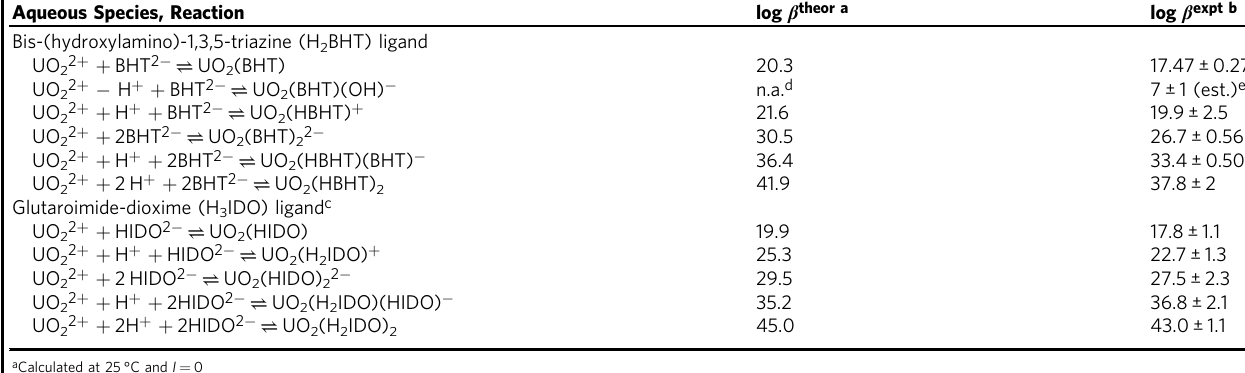
a Calculated at 25°C and I = 0 b Obtained at 25°C and I = 0.5M c Experimental (25°C, I = 0.5M) and computational (25°C, I = 0) data are taken from our past works 35,38 d n.a. — no available value e est. — estimated value based on speciation modeling